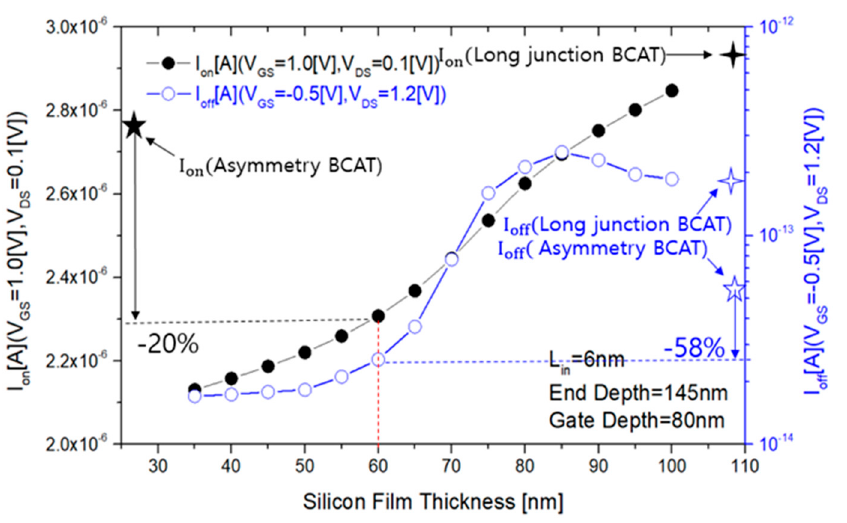
Figure 10. Changes in I on and I off according to the silicon film of Pi-BCAT.